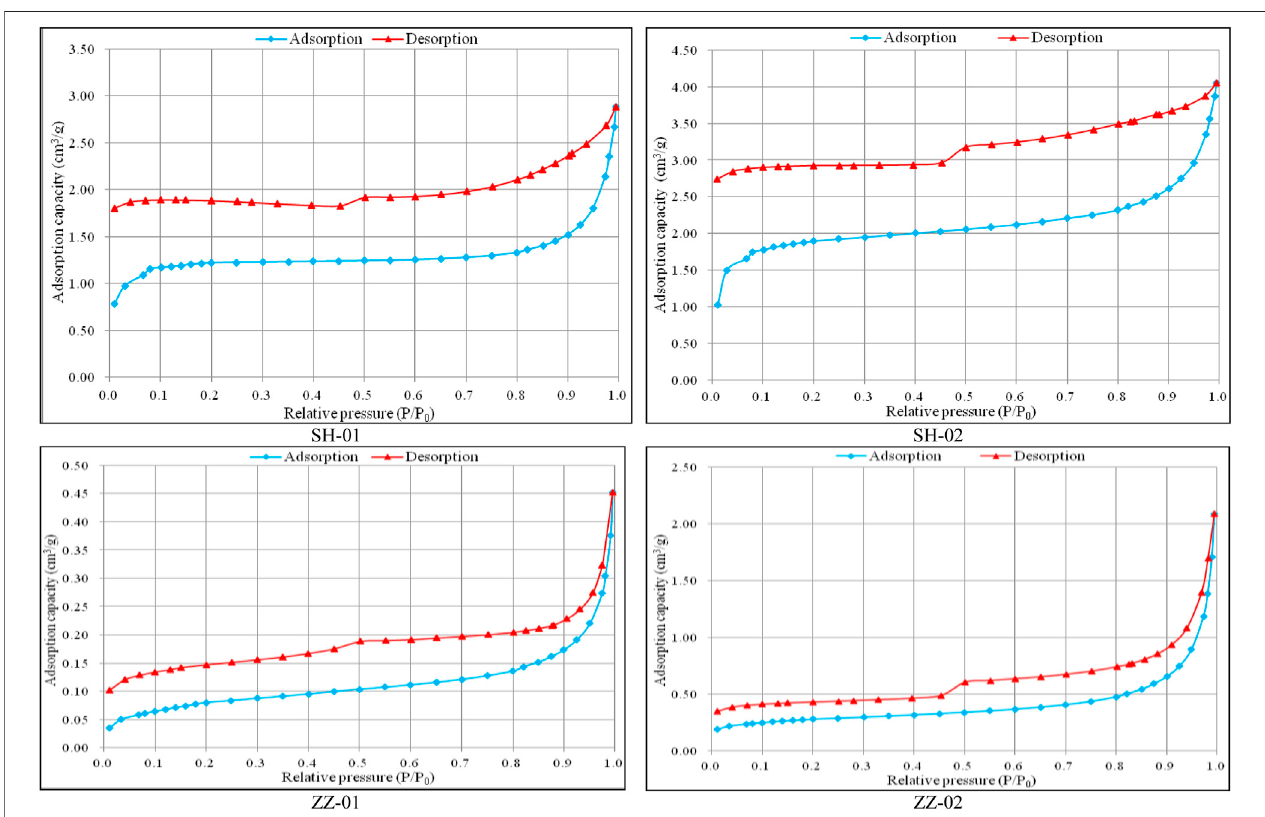
FIGURE 5 | Low temperature nitrogen adsorption-desorption